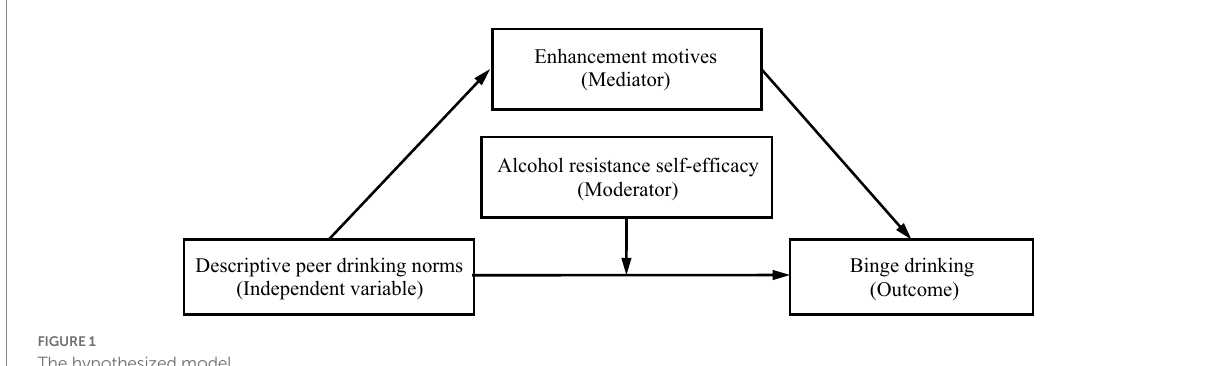
FIGURE 1 The hypothesized